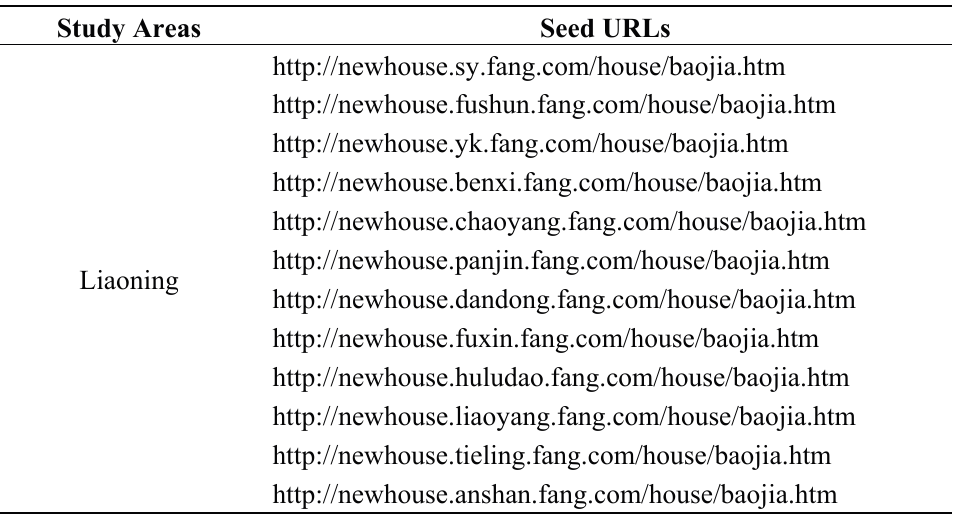
Table 1. Seed Uniform Resource Locators (URLs) of the six